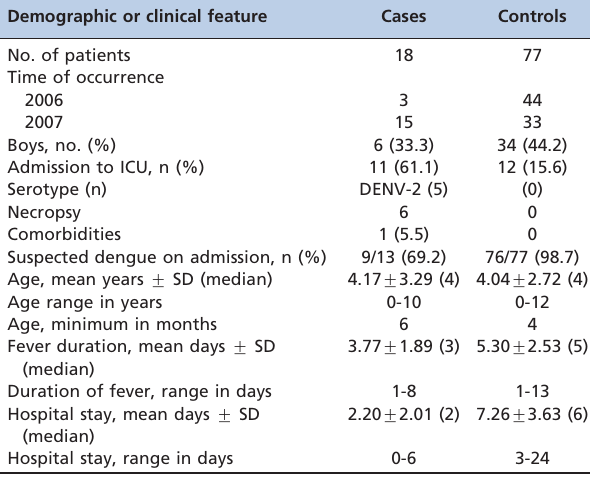
Table 1 - Demographic and clinical features of children with severe dengue.